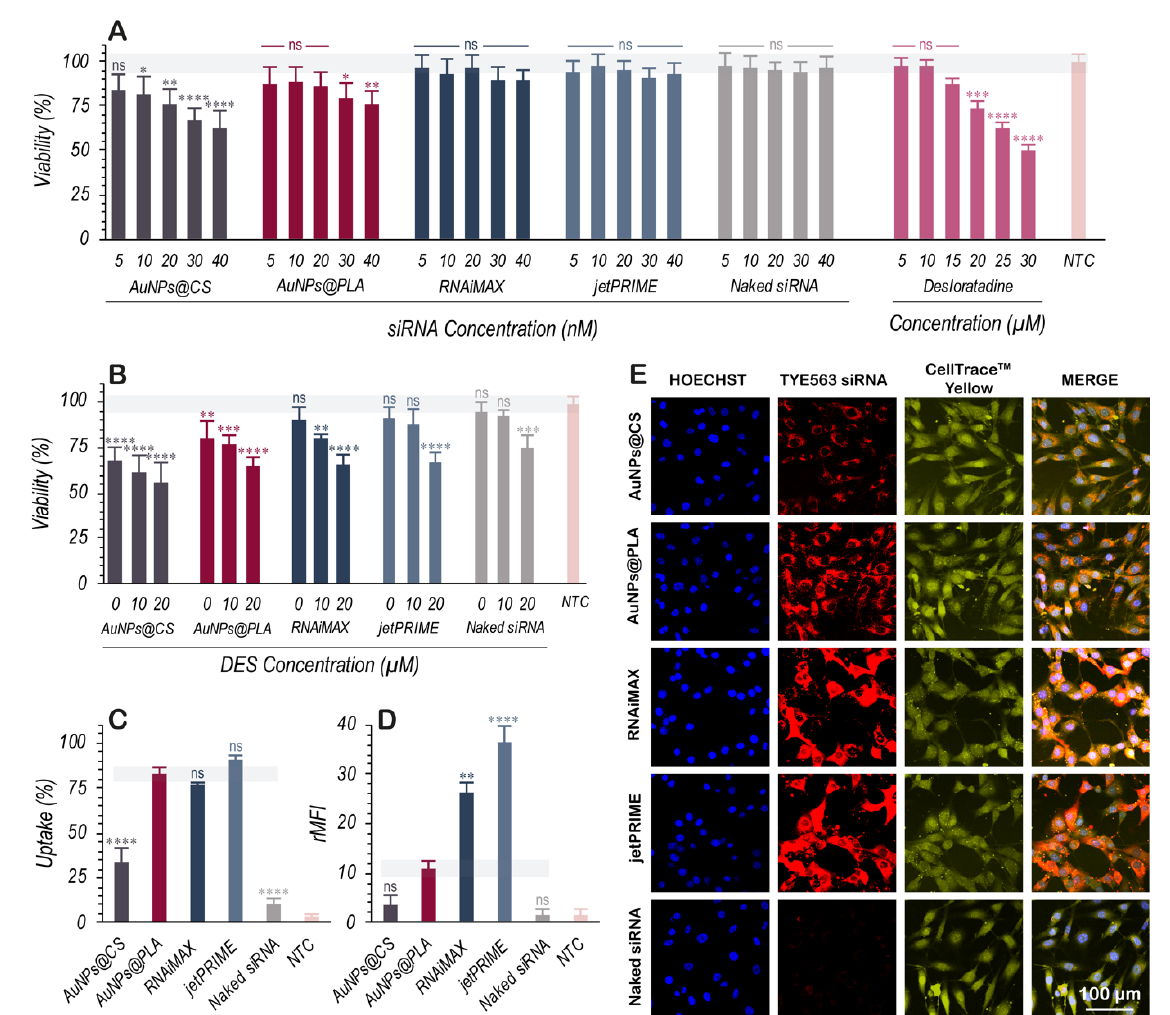
Figure 2. Cytotoxicity and evaluation of nanoformulation internalization in NIH-3T3 cells. ( A ) Cell viability of NIH-3T3 cells was measured by CellTiter GLO ® after 4 h incubation with AuNPs@CS, AuNPs@PLA, RNAiMAX, jetPRIME ® , and Naked siRNA at different concentrations (5, 10, 20, 30, and 40 nM of siRNA). The cytotoxic effect of 20 h incubation with DES at different concentrations (5, 10, 15, 20, 25, and 30 µM) was tested as well. ( B ) Cell viability of NIH-3T3 cells after 4 h incubation with the nanoformulations and transfection reagents (30 nM effective concentration of siRNA), washing and 20 h incubation with DES (0, 10, and 20 µM). ( C ) Uptake percentage (=% positive cells) and ( D ) relative mean fluorescence intensity per cell of TYE563 siRNA-labeled nanoformulations and transfection reagents (30 nM) after 4 h treatment on NIH-3T3 cells as determined by flow cytometry. ( E ) Confocal images of NIH-3T3 cells after 4 h treatment with different nanoformulations and transfection reagents at 30 nM effective concentration of siRNA. Nuclei were stained with Hoechst 33342 (blue), the cytoplasm with CellTrace™ Yellow (yellow), while TYE563 siRNA is shown in red. The scale bar corresponds to 100 µm. Data are represented as the mean ± the standard deviation for a minimum of three independent experiments. Statistical significance is indicated when appropriate, in ( A , B ) when referring to not treated control (NTC) and in ( C , D ) when compared to AuNPs@PLA. (ns = not significant p > 0.05, * p ≤ 0.05, ** p ≤ 0.01, *** p ≤ 0.001, **** p ≤ 0.0001).